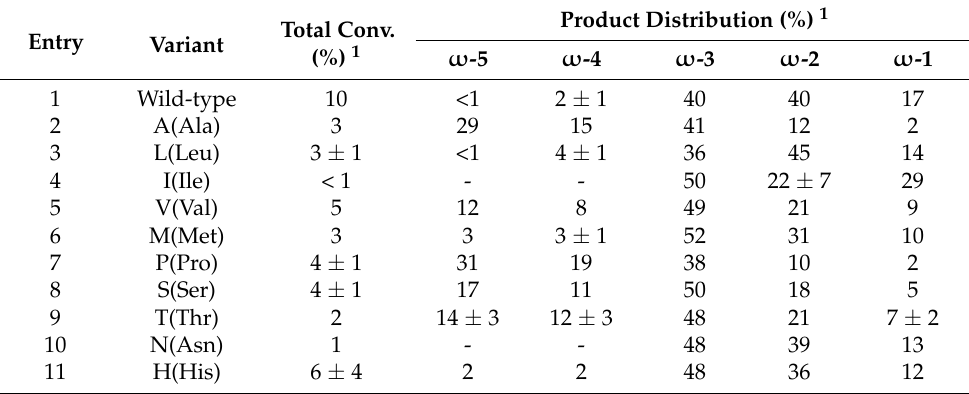
1 Both total conversion percentages and product distributions are given as averages of two separate measurements. Standard errors are displayed only for cases where the error is around 20% or over of the mean value, or for significant products. Table 3. Total conversion levels and product distribution for the conversion of C12:0 substrate by A331 site-saturation mutants of BAMF2522 (Alanine 331 position was replaced by all other amino acids). Only mutants that exhibited detectable activity are shown. Total Entry Variant